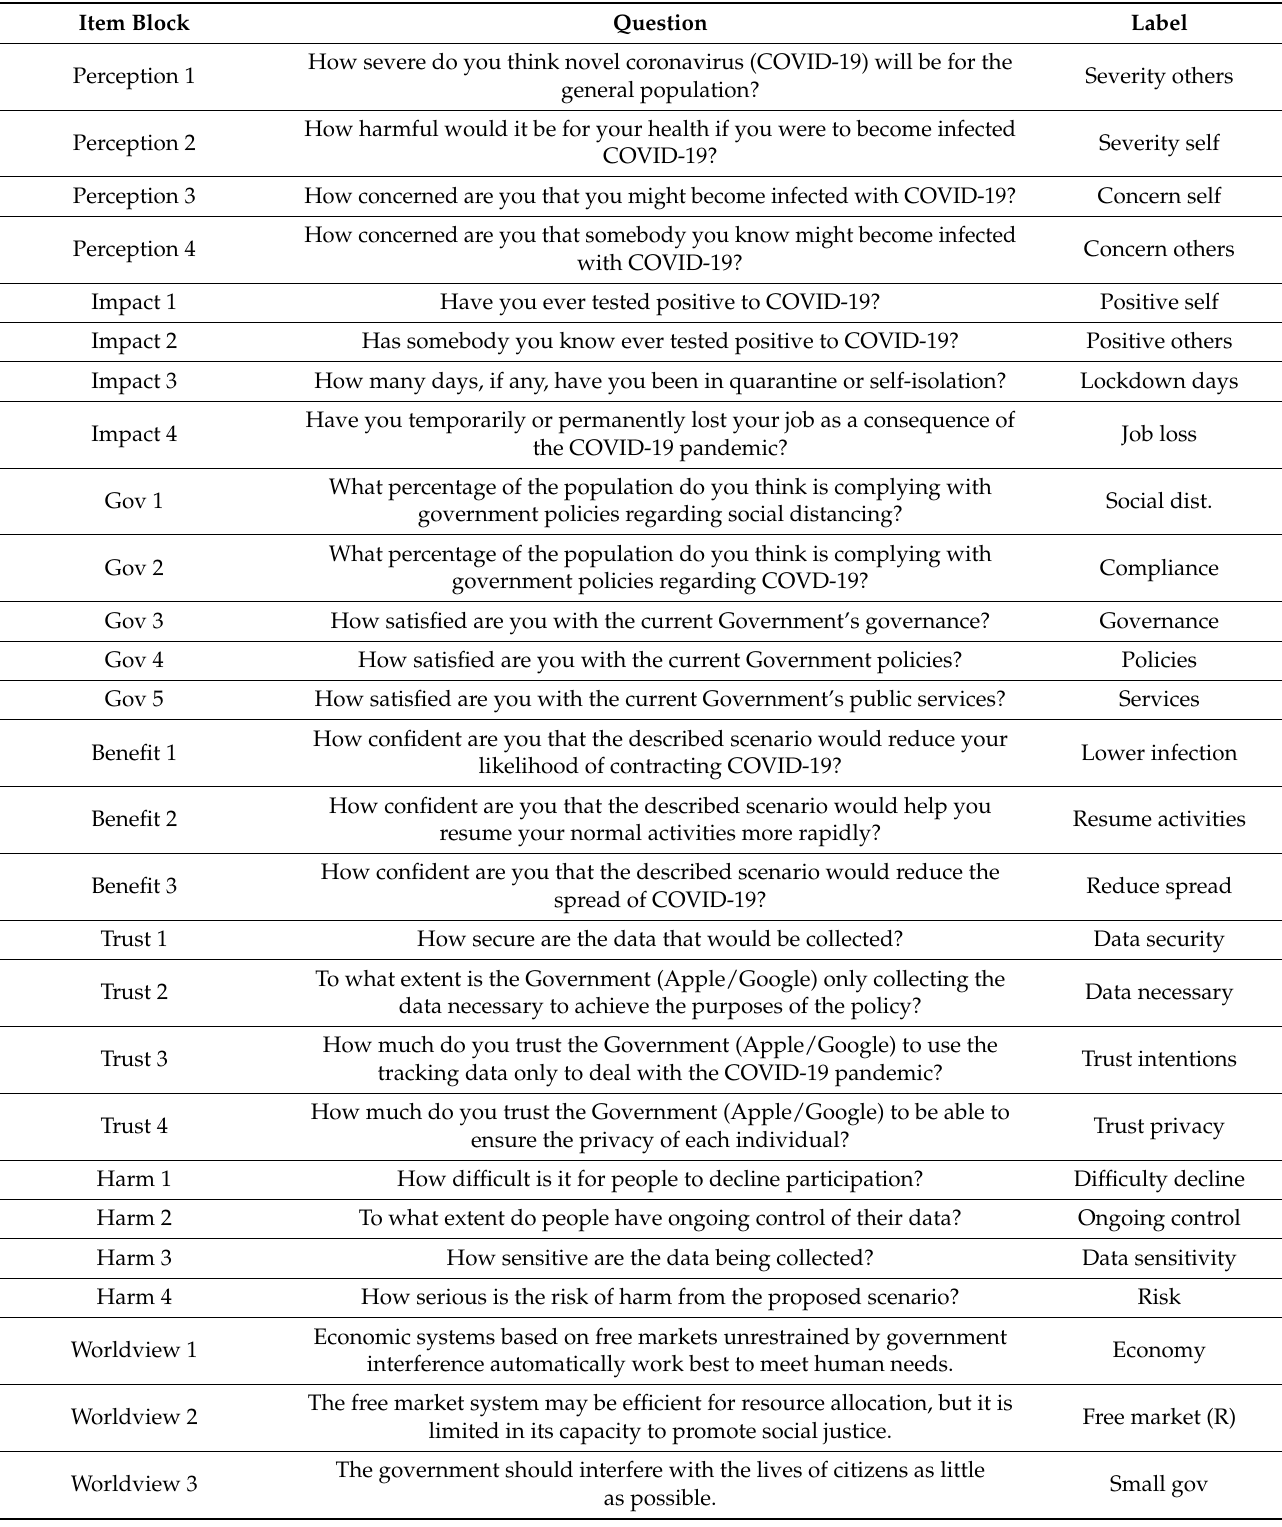
Table 2. COVID-19 perceived risk and impact, government perceptions, tracing technology (scenario) questions (benefits, trust and harm), and worldview items. Reverse-scored items are denoted with